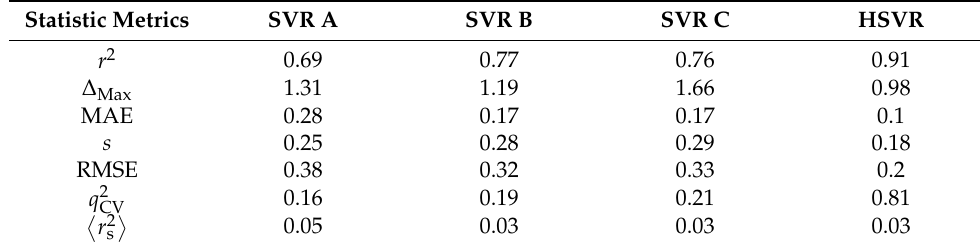
Table 2. Statistic metrics including r 2 , ∆ Max , mean absolute error (MEA), s , root mean square error (RMSE), q 2 , and assessed by support vector regression (SVR) A, SVR B, SVR C, and hierarchical CV support vector regression (HSVR) in the training set.